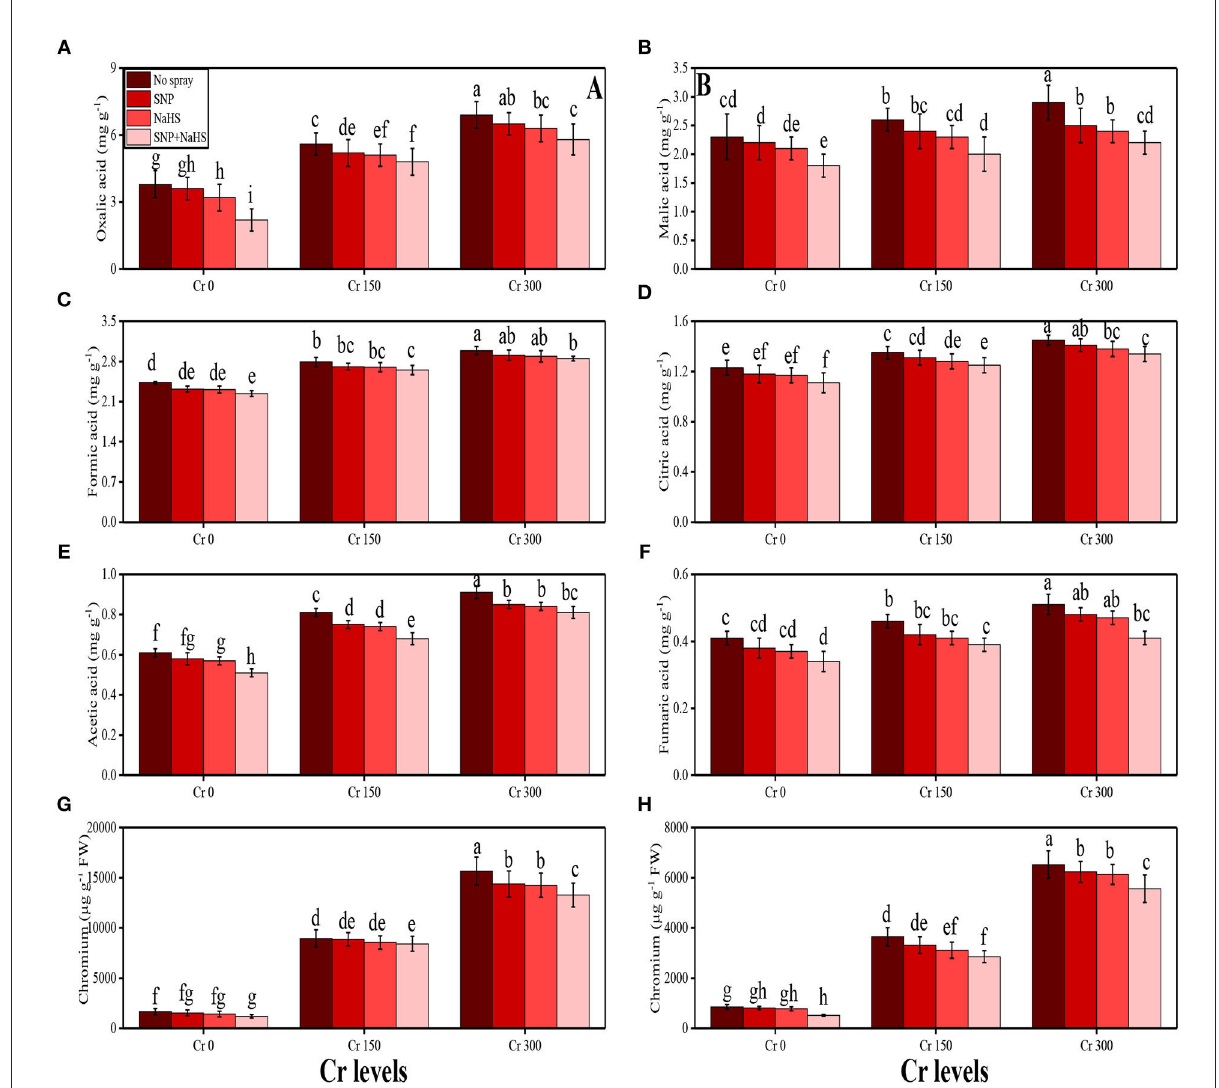
FIGURE6 Impact of individual and combinatorial application of SNP and NaHS on organic acids and Co uptake, i.e., oxalic acid content (A) , malic acid content (B) , formic acid content (C) , citric acid content (D) , acetic acid content (E) , and fumaric acid content (F) in the roots, Cr content in the roots (G) , and Cr content in the shoots (H) of spinach ( S. oleracea ) plants grown under different levels of Cr [0 (no Cr), 150, and 300 µ M] in sandy loam soil. Values in the figures indicate just one harvest. Mean ± SD ( n = 4). Two-way ANOVA was performed and mean differences were tested by HSD ( P < 0.05). Different lowercase letters on the error bars indicate significant differences between the treatments.